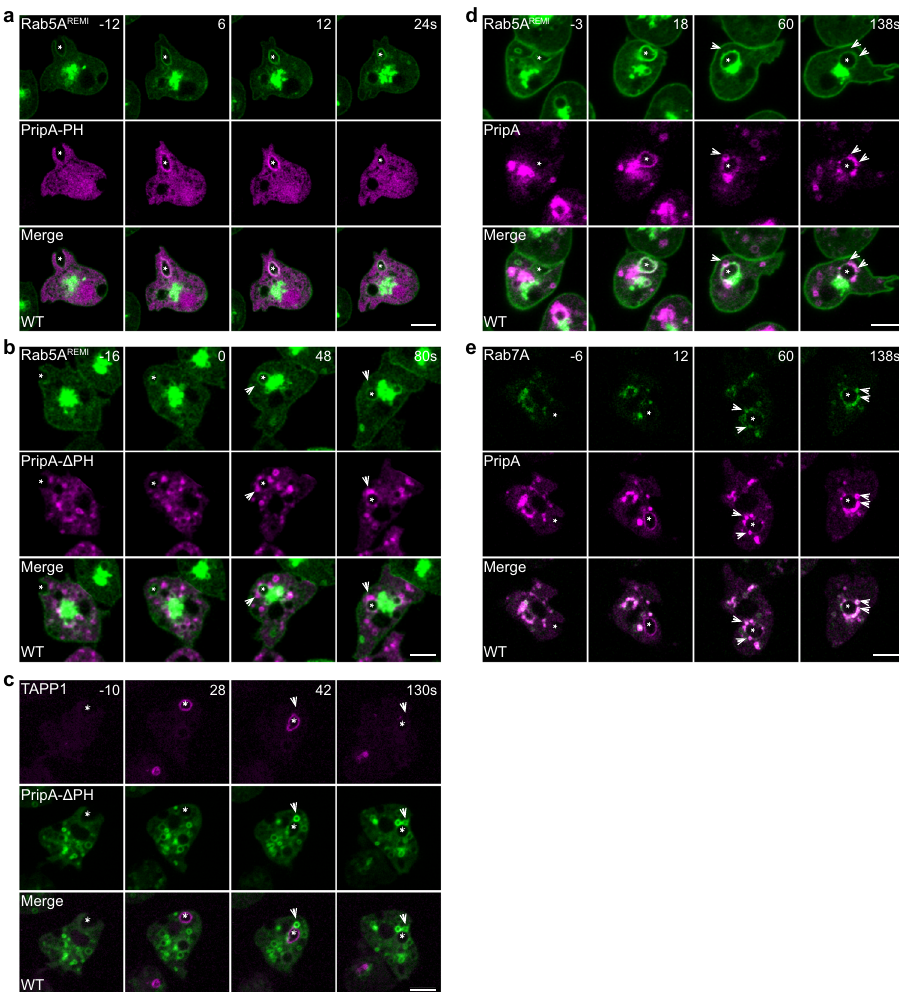
Fig. 5 Time-lapse images of protein localization during macropinocytosis. a Colocalization of GFP-Rab5A REMI and PripA-PH-RFP on nascent macropinosomes. b Localization of GFP-Rab5A REMI and PripA- Δ PH-RFP. c Localization of TAPP1-RFP and PripA- Δ PH-GFP. d Localization of GFP-Rab5A REMI and PripA-RFP. e Localization of GFP-Rab7A and PripA-RFP. In all panels, the asterisks mark newly formed macropinosomes and the arrows mark vesicles that gather around the newly formed macropinosomes. Scale bar = 5 μ